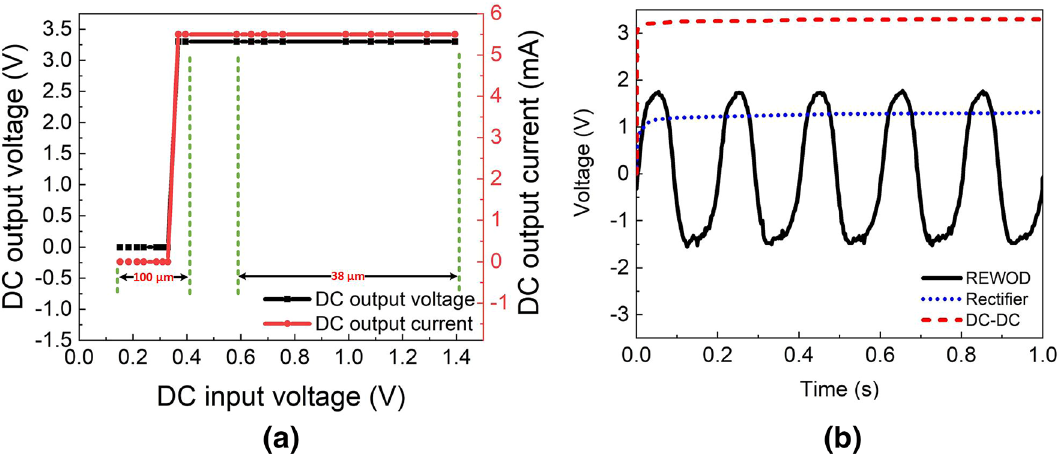
Figure 9. ( a ) Output voltage and current of the DC–DC converter for the harvested energy using 38 µ m and 100 µ m, ( b ) instantaneous voltage output from the REWOD, rectifier, and DC–DC converter.